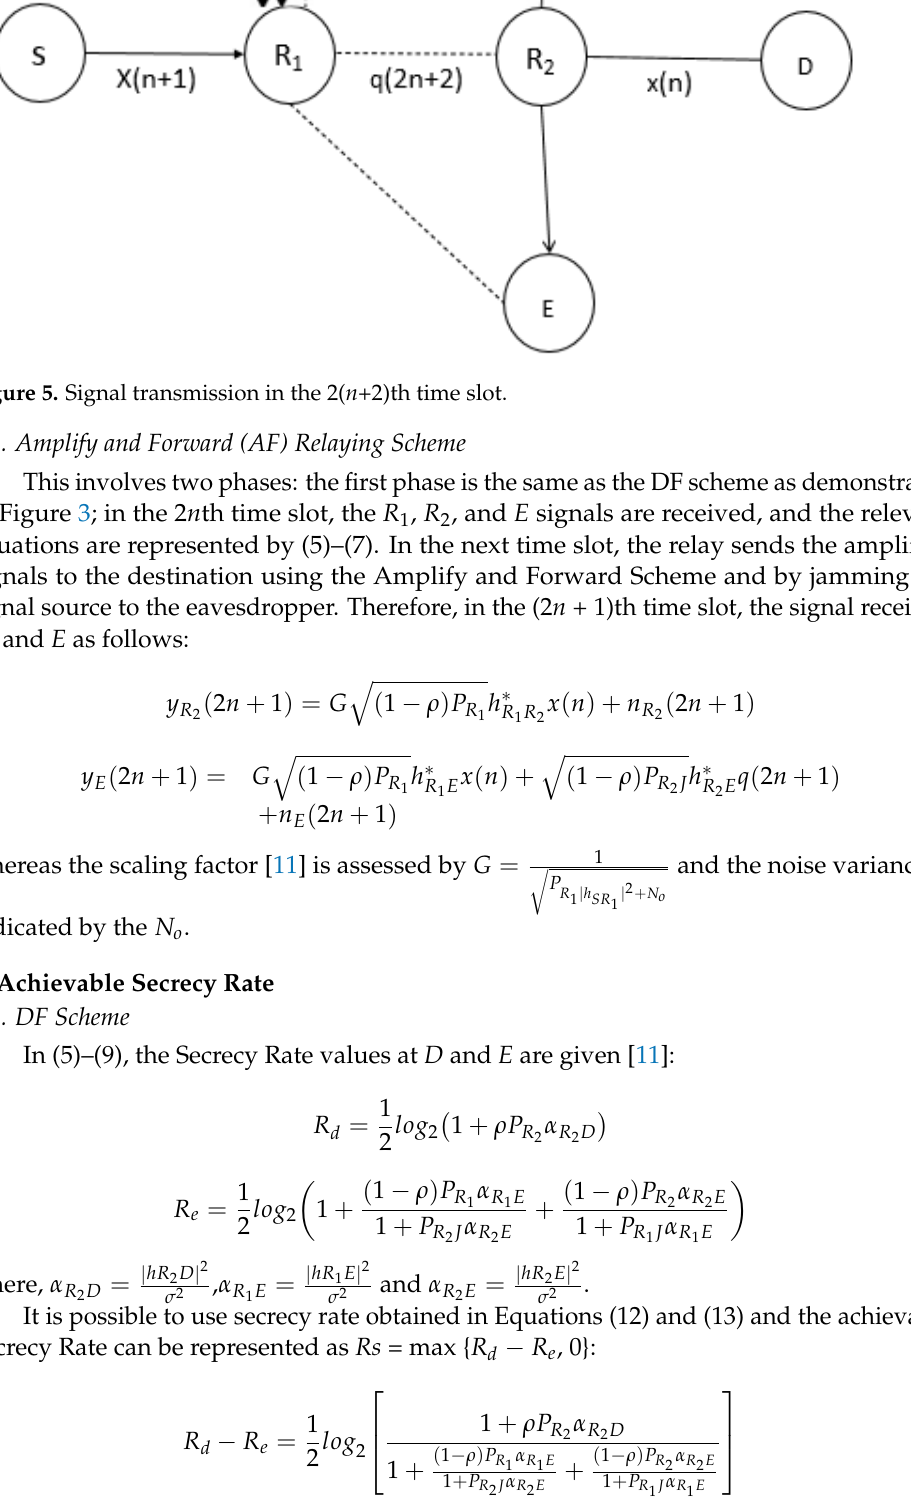
Figure 4. Transmission of signals in the 2( n + 1)th time slot.